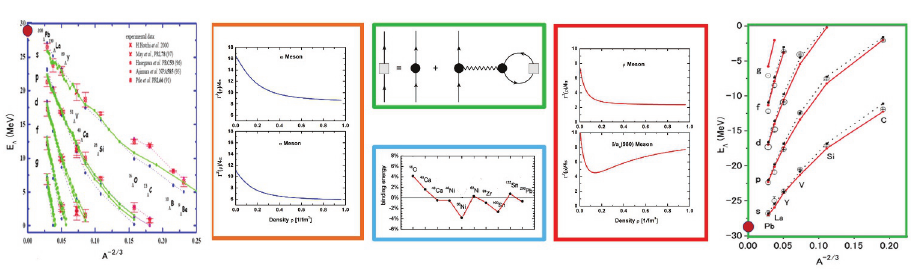
Figure 1. DDRH vertices derived from DBHF self–energies. The diagram in the upper center represents the dressed vertices (boxes) as given by the bare NN–meson couplings ( fi lled circles). Baryon and meson propagators are indicated by straight and wavy lines, respectively. The resulting isoscalar and isovector coupling functionals are shown at the left ( ω , σ ) and the right ( ρ , δ / a 0 (980)) , respectively. Applications to stable nuclei over the mass chart are illustrated in the lower center by displaying the relative deviations of calculated and experimental binding energies. Also shown are mean– fi eld results for single– Λ separation energies: on the far left covariant DDRH results and on the very right non– relativistic results obtained by a folding approach using the G–matrix from the ESC-08 interaction [17] are shown. For further details see Ref.